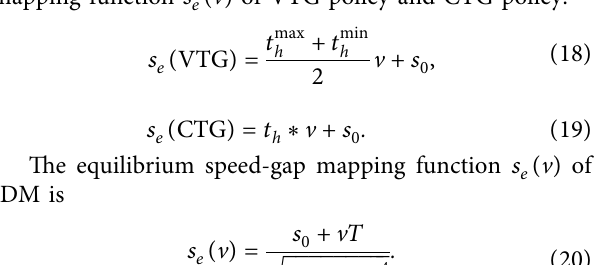
on stability. (b) Effect of Δ v c on